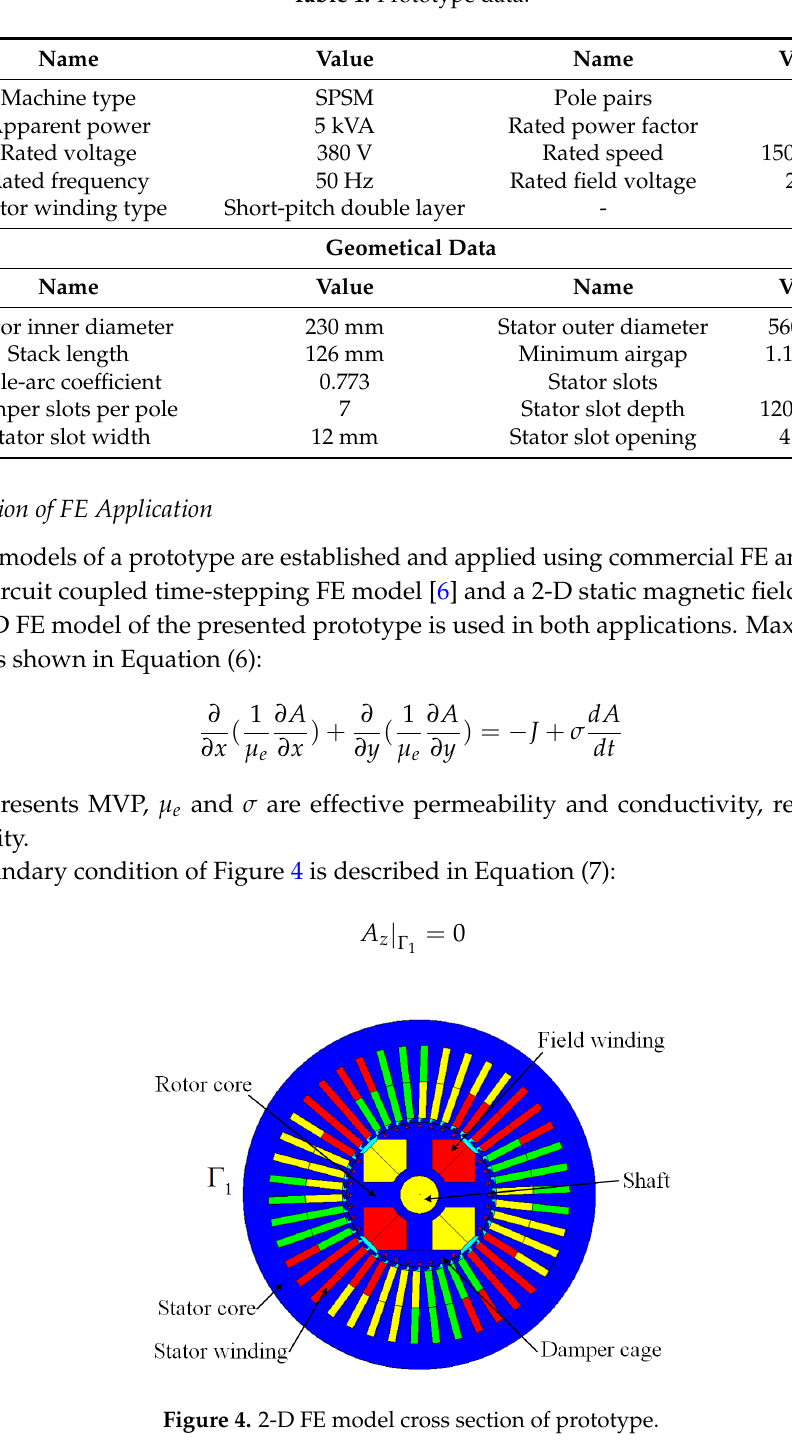
Table 1. Prototype data.